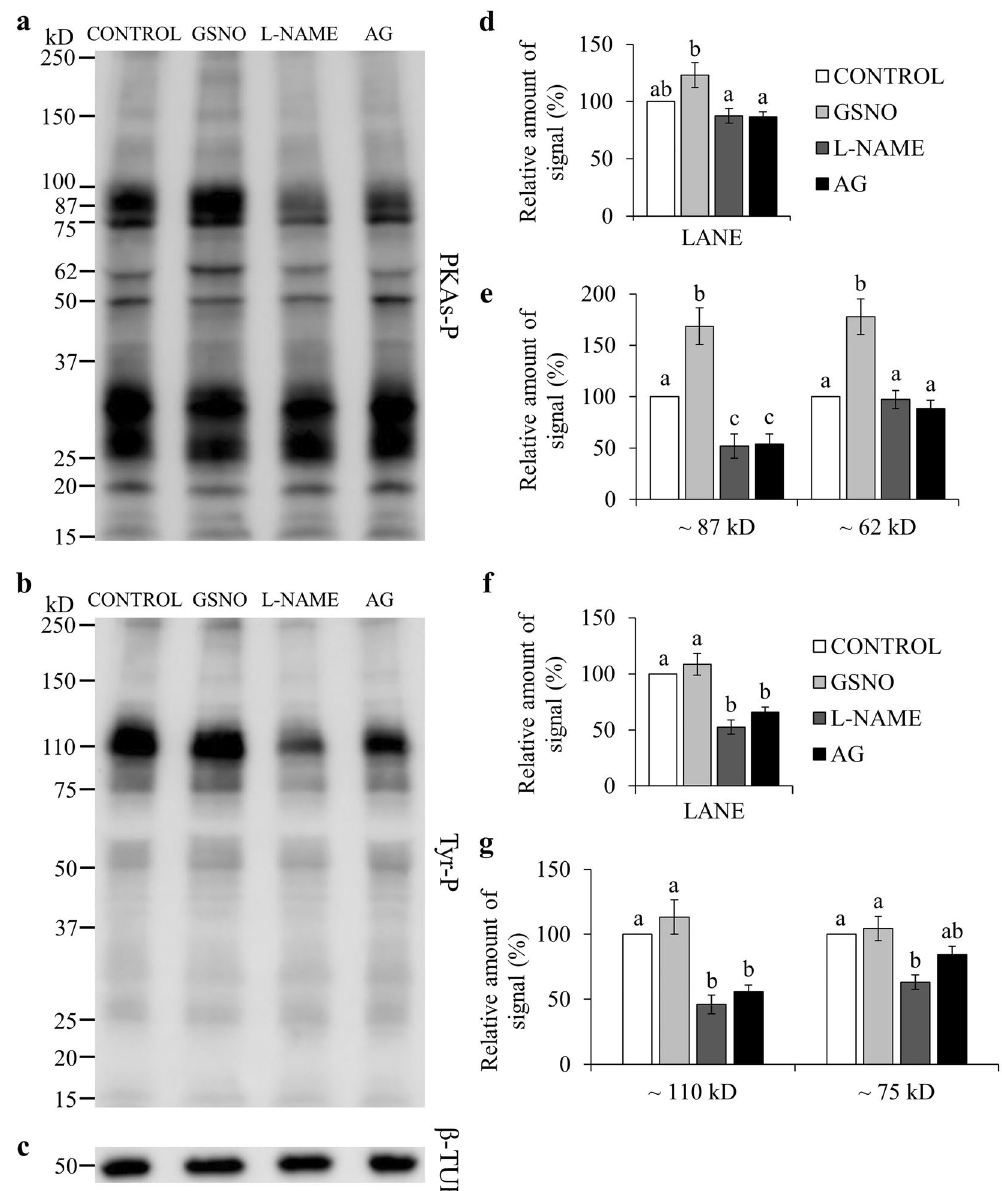
or in the presence of GSNO, a NO donor, and l-NAME and AG (both NOS inhibitors). ( a,b ) Sperm protein extracts (n = 7) were analyzed for phosphorylation by Western blot using anti-PKAs-P or anti-Tyr-P as first antibodies, respectively. ( c ) β-tubulin (β-TUB) was used as a protein loading control. For signal quantification, each lane was normalized to its β-TUB optical density value. ( d–g ) Relative amount of signal quantified in each membrane using ImageQuant TL v8.1 software for PKAs-P and Tyr-P, respectively. Different letters (a, b, c) indicate statistically significant differences ( P < 0.05) between groups. Images ( a – c ) were cropped from the corresponding blot showed in Supplementary Fig. S1 (lanes